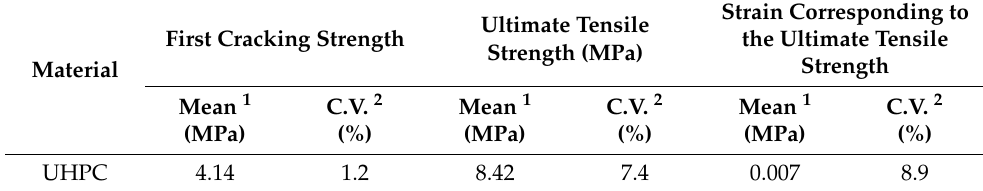
Table 4. Tensile properties of UHPC.